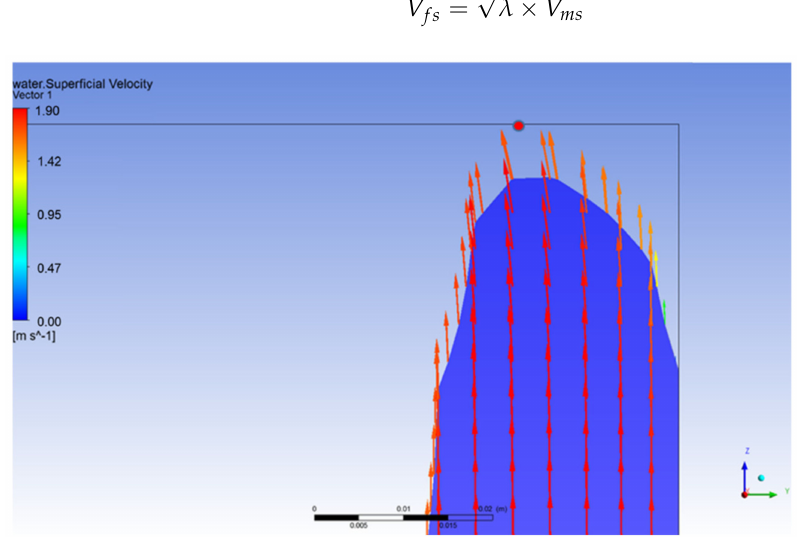
Figure 13. Vector plot of fluid velocity at 5.75148